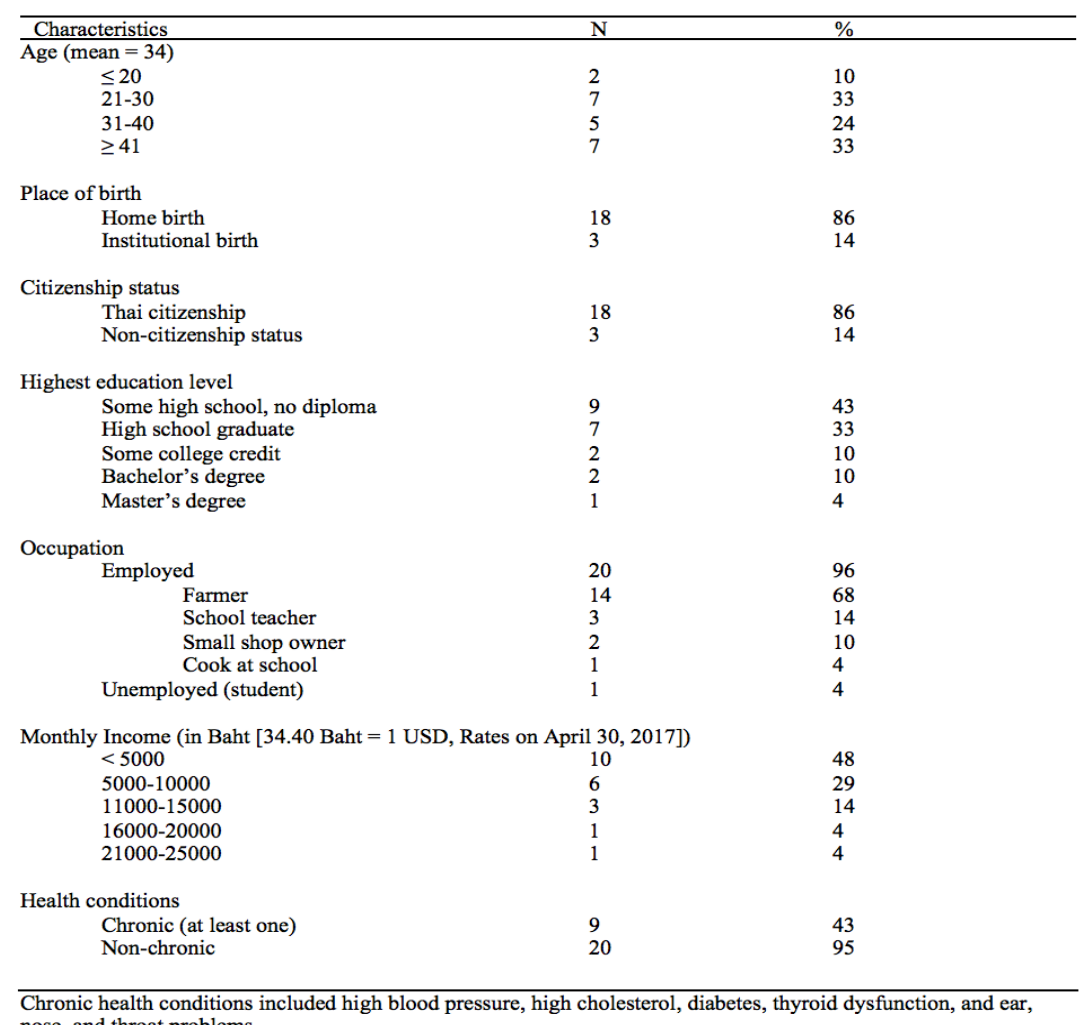
Table 1. Demographic Characteristics of the Study Sample of 21 Participants for at least a month after delivery is important to prevent further cooling. We believe it will give strength and protect mother and baby from getting sick” (Participant